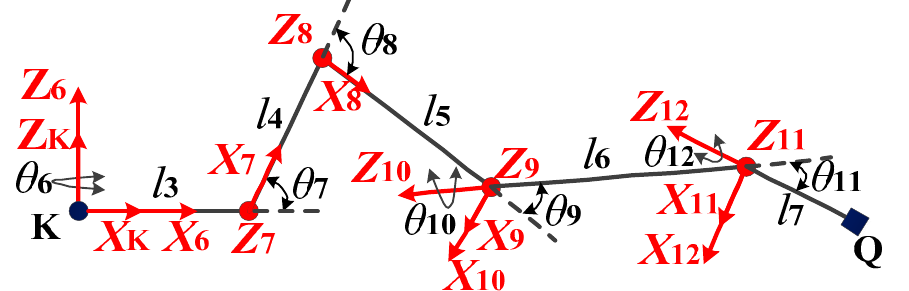
Figure 11. Kinematic model of the manipulator. Table 2. D–H parameters of the manipulator.